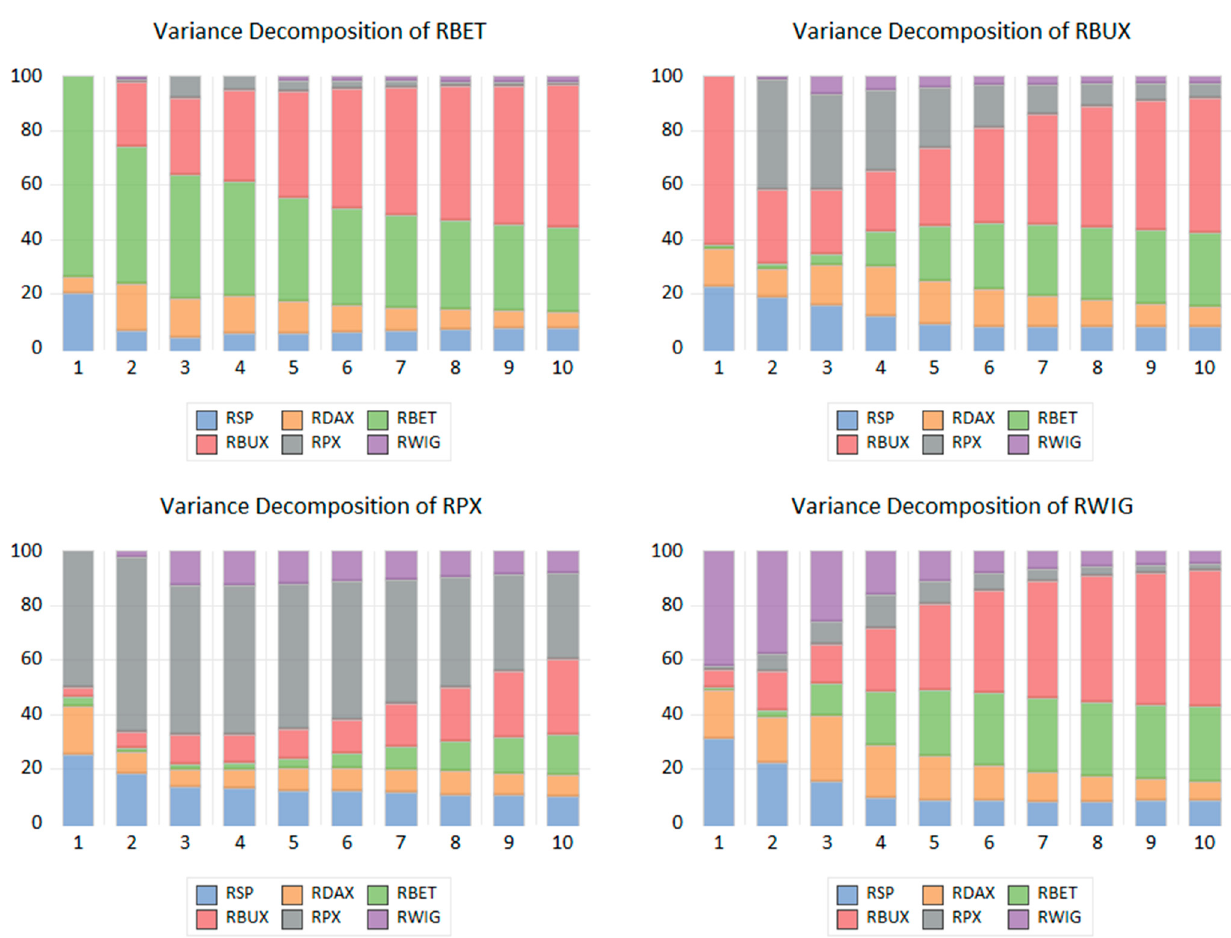
Figure A11. Cont